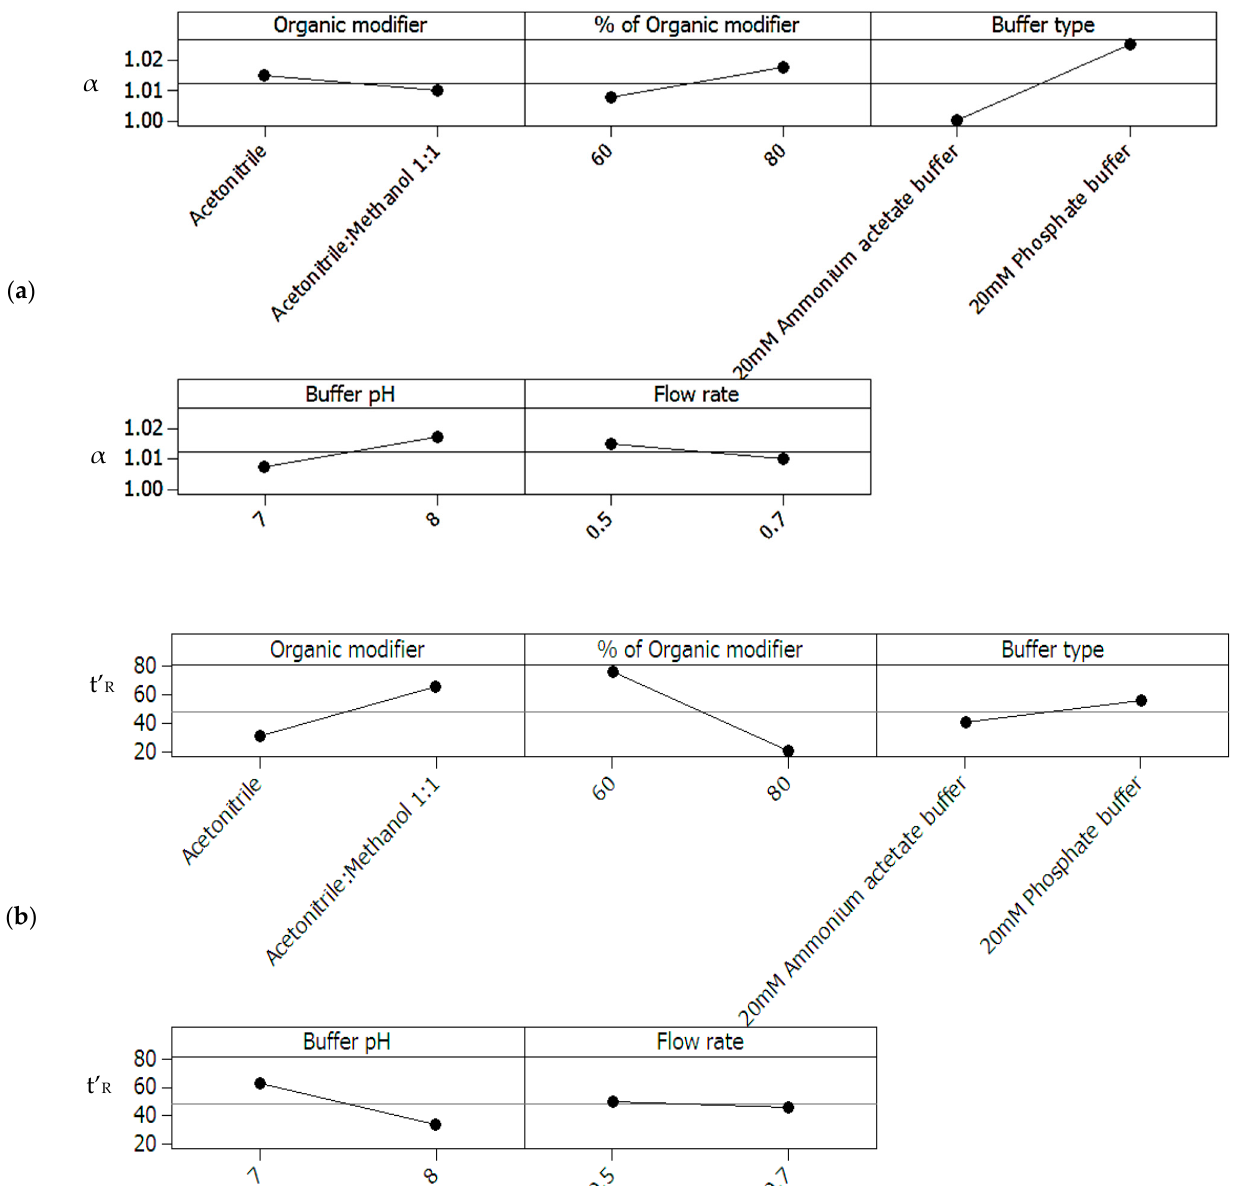
Figure 2. ( a ) Screening design for peak separation: main effects plots for separation factor ( α ) of the critical peak pair of (4 ′ OHC) enantiomers, ( b ) Screening design for retention time: main effects plots for adjusted retention time (t’ R ) of the last eluted peak ( R -CAR).